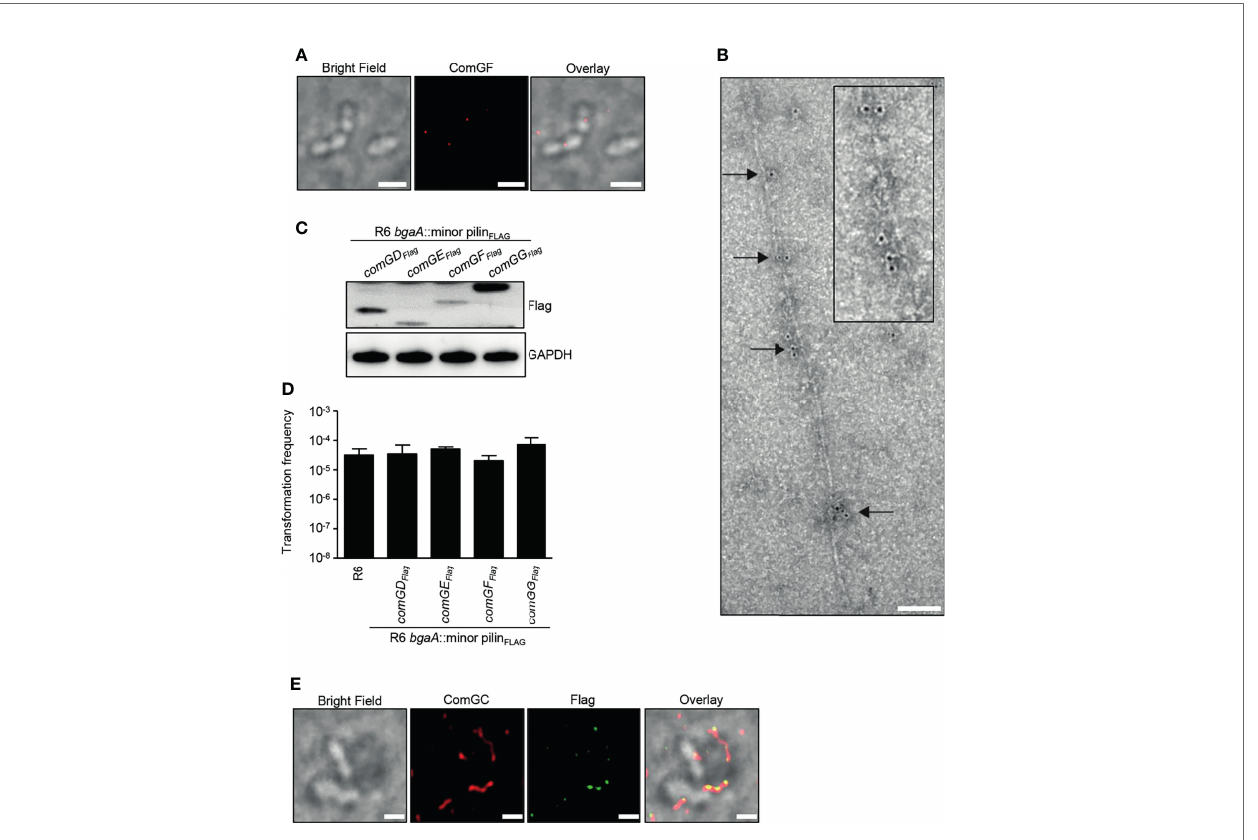
FIGURE 5 | Visualization of the minor pilin ComGF. (A) BF and IF microscopy of competent WT R6 bacteria stained with anti-ComGF antibodies (red). Scale bars represent 2 µm. (B) Immunogold electron microscopy of competent WT R6 bacteria. Electron micrographs were stained with anti-ComGF antibodies and secondary antibodies conjugated to 6-nm gold particles. Black arrows indicate gold particles incorporated throughout the pilus fi lament. The inset (black box) shows an enlargement of the immunogold-labelled pilus. Scale bar represents 100 nm. (C) Bacterial whole cell lysates of R6 strains encoding an extra copy of C-terminal Flag- tagged comGD , comGE , comGF or comGG in the bgaA locus were analysed by immunoblotting using Flag-antiserum. GAPDH was used as loading control. (D) Transformation frequency of WT R6 and R6 strains encoding an extra copy of C-terminal Flag-tagged minor pilins. The error bars represent the standard deviation of a minimum of three independent experiments (n=3). (E) Co-localization of ComGF Flag and ComGC visualized by IF microscopy. Competent bacteria ectopically expressing Flag-tagged ComGF (R6 bgaA :: comGF Flag ) were labelled with primary antibodies speci fi c for ComGC (red) and anti-Flag antibodies (green). Bacteria were visualized by BF microscopy. Scale bars correspond to 1